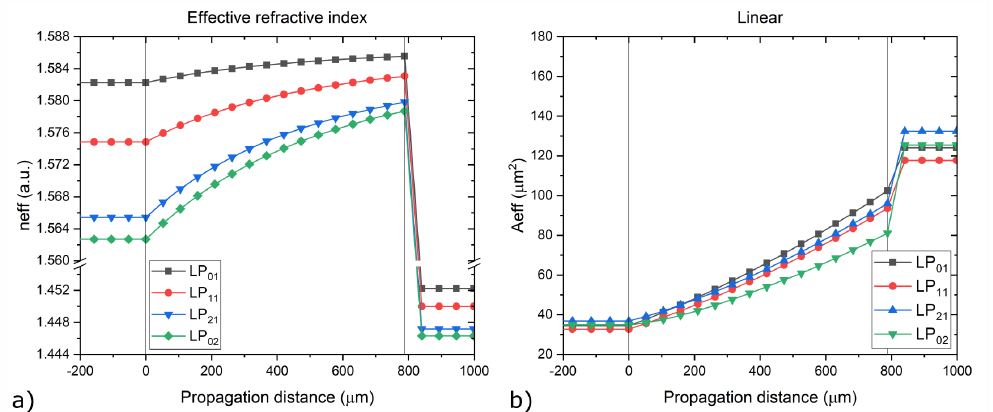
Figure 5. Modal propagation conditions of an MFA with lineal profile matching only the diameters of the cores from the PIC to the FMF. ( a ) Effective refractive indices and ( b ) effective mode areas for the different LP fiber